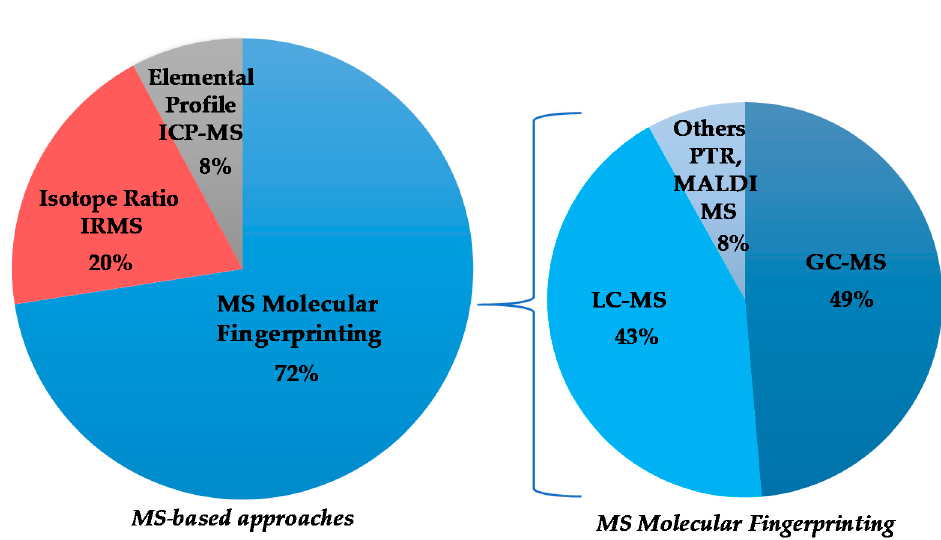
Figure 3. Graphical representation of the partition of selected mass spectrometry (MS)-based studies on extra virgin olive oils (EVOOs)’ geographical origin